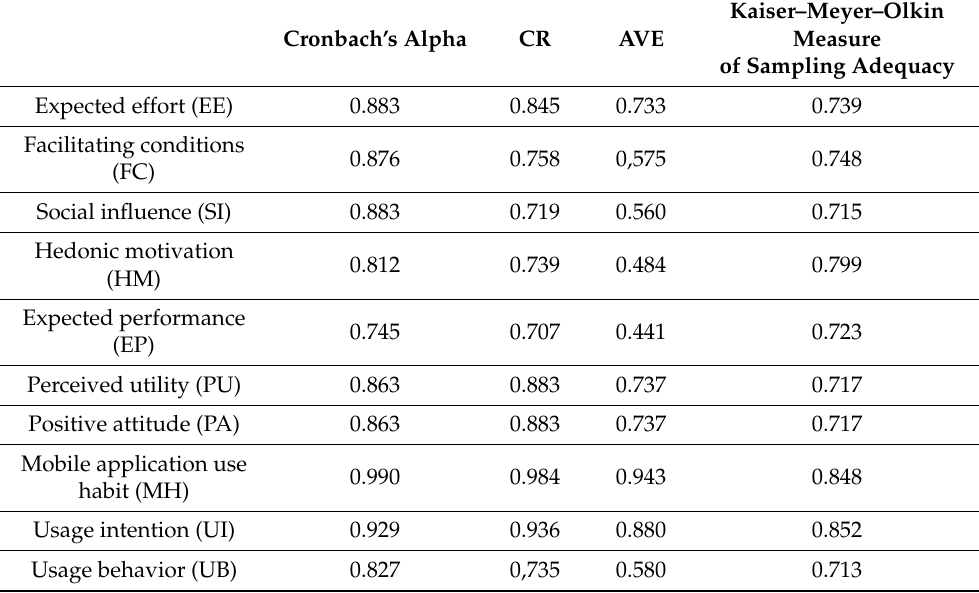
Table 2. The measurement model